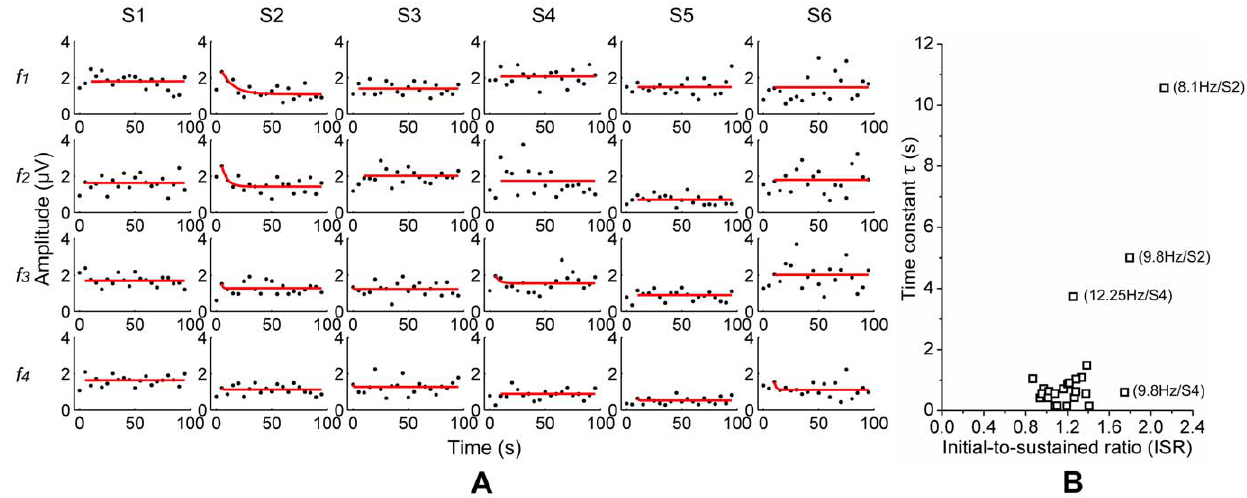
Figure 5. Adaptation fittings of mean time courses and the corresponding ISR/ t plot. (A) The mean time courses and fitted exponentials of SSMVEP amplitudes on Oz site. Each symbol represents the mean amplitude averaged in the same trial order. (B) Scatter plot of the relationship between ISR and time constant t for each motion reversal frequency and each subject. Each symbol represents an ISR/ t pair.